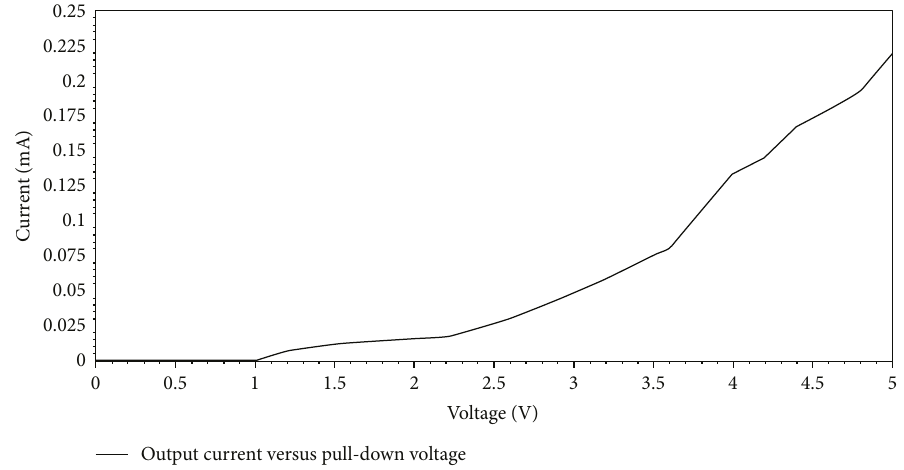
Figure 10: Input voltage versus output